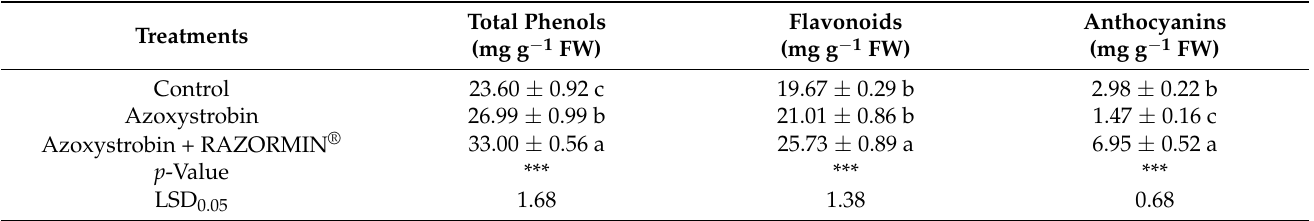
Table 11. Effect of the application of the biostimulant RAZORMIN ® on some antioxidant compounds in pepper plants subjected to the fungicide